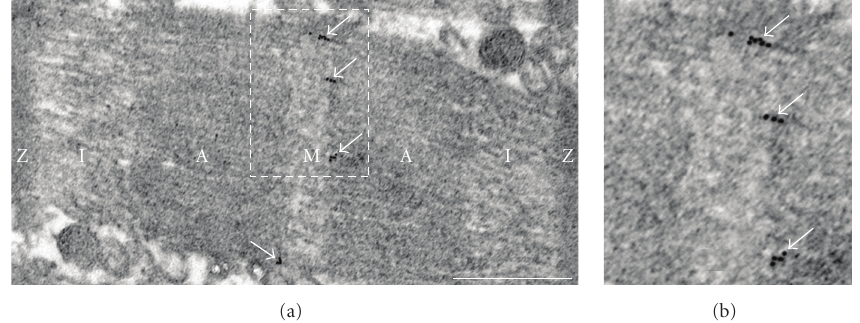
Figure 4: Ultrathin cryo-sections of adult mouse FDB skeletal muscle were labeled with antibodies specific for the COOH-terminal insertion present in MyBP-C slow variant 1. (a) Variant 1 was detected at the periphery of the M -band (arrows). The boxed area in (a) is blown up in (b) for ease of visualization of the immunolabeling. Scale bar corresponds to 0.5 μ